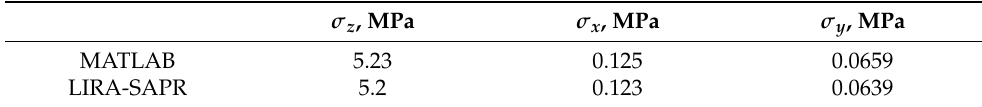
Table 1. Comparison of maximum stresses in LIRA-SAPR and MATLAB.